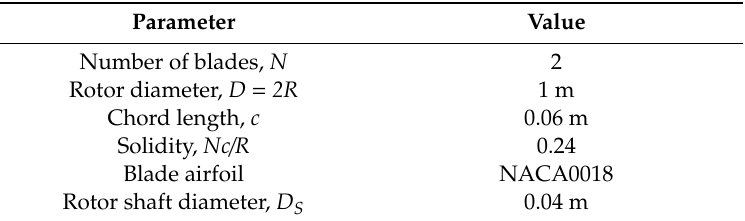
Table 1. Design specifications of the analyzed wind turbine.